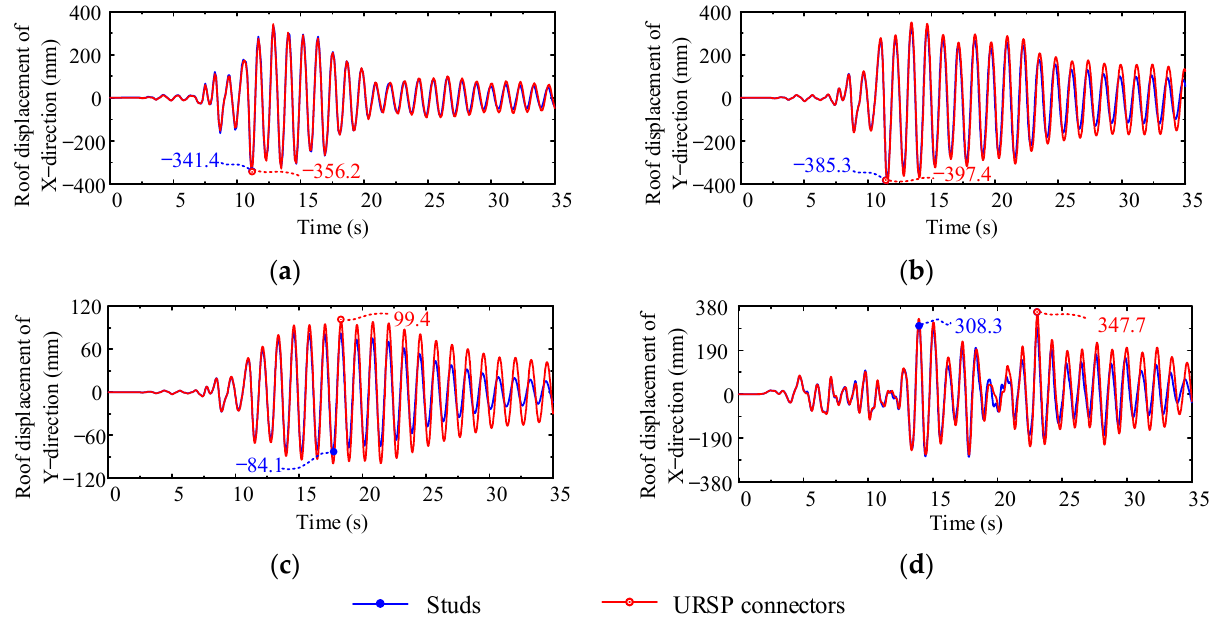
Figure 8. Roof displacement: ( a ) case XL1; ( b ) case YL1; ( c ) case YS1; ( d ) case XL2. Table 2. Ratios of the maximum roof displacements.